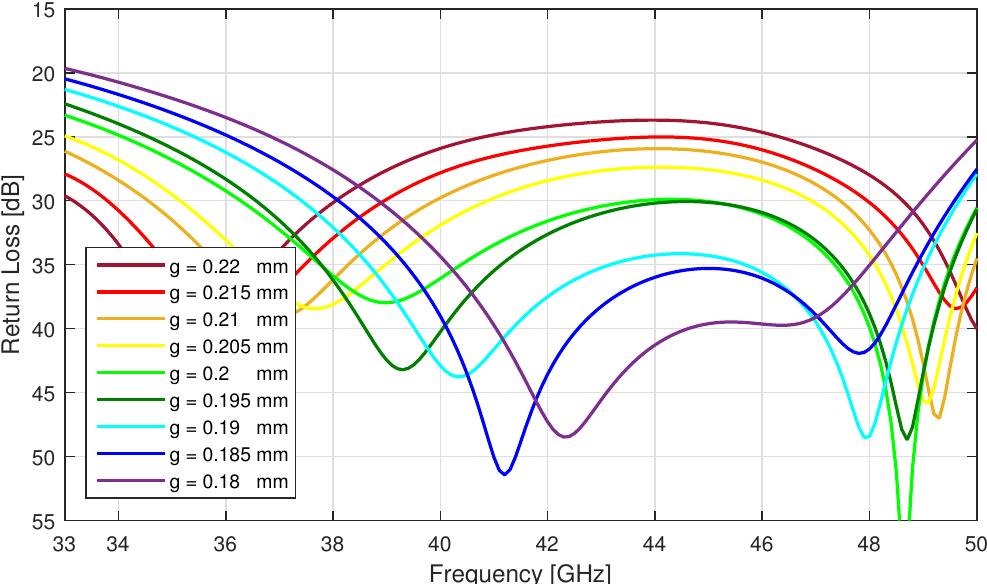
Figure 10. Return loss of the transition step shown in Figure 9. The g parameter modifies the impedance in the WG r step and introduces a mismatch with the coaxial cable which affects the